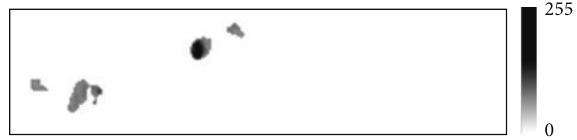
Figure 3: An example of load distribution data of one sampling time.